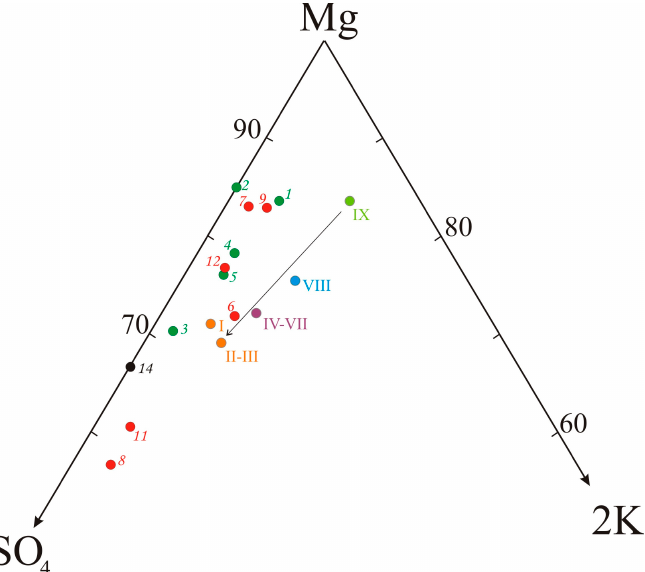
Figure 7. The chemical composition of brines on the Mg–2K–SO 4 chart; point numbers according to Table 2.